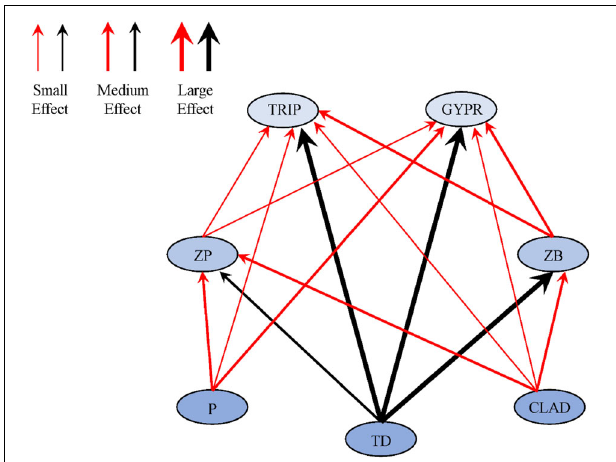
FIGURE 5 | Schematic diagram of the strengths of trophic links investigated in this study. The width of the arrows between resources and consumers reflects estimated effect sizes: small (0–0.2), medium (0.21–0.5), and large (0.51 and above). Positive effects sizes and negative effects sizes are represented in red and black,